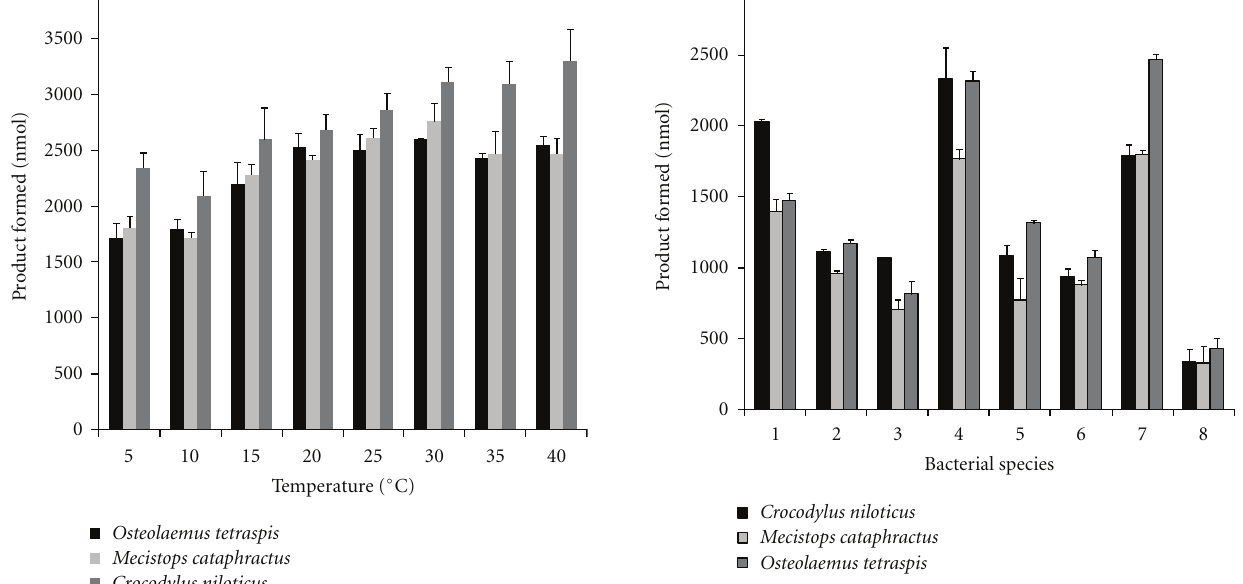
Figure 5: Phospholipase A 2 activity of Osteolaemus tetraspis , Mecistops cataphractus , and Crocodylus niloticus serum against dif- ferent bacterial species. The results represent the means ± standard deviations of four independent determinations. 1; Enterobacter cloacae , 2; Shigella flexneri , 3; Salmonella typhi , 4; Klebsiella oxytoca , 5; Providencia stuartii , 6; Streptococcus pyrogens , 7; Streptococcus faecalis , 8; Staphylococcus aureus